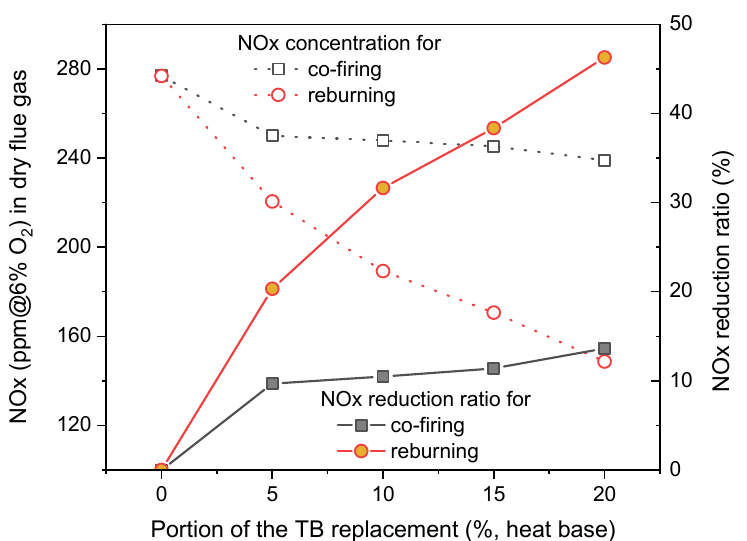
Figure 5. NOx emission and degree of NOx reduction for various TB cofiring and reburning ratios.